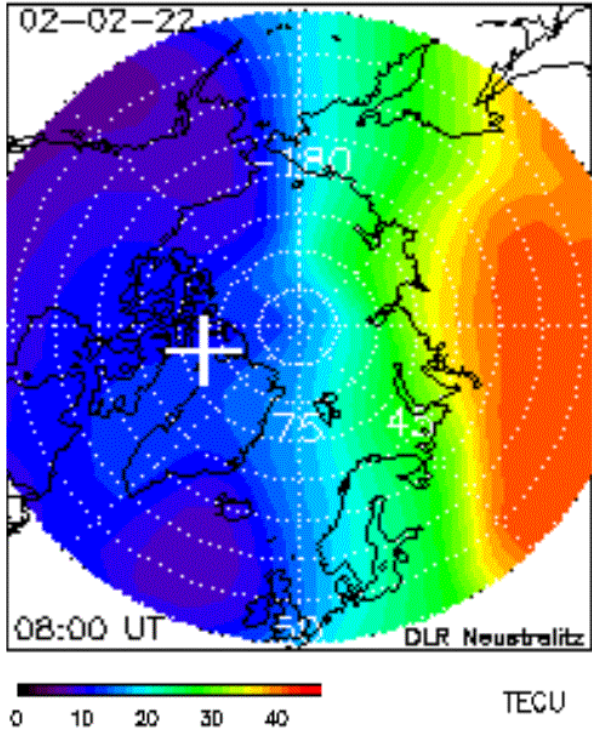
Fig. 9. Same as Fig. 3, but for the event on 22 February